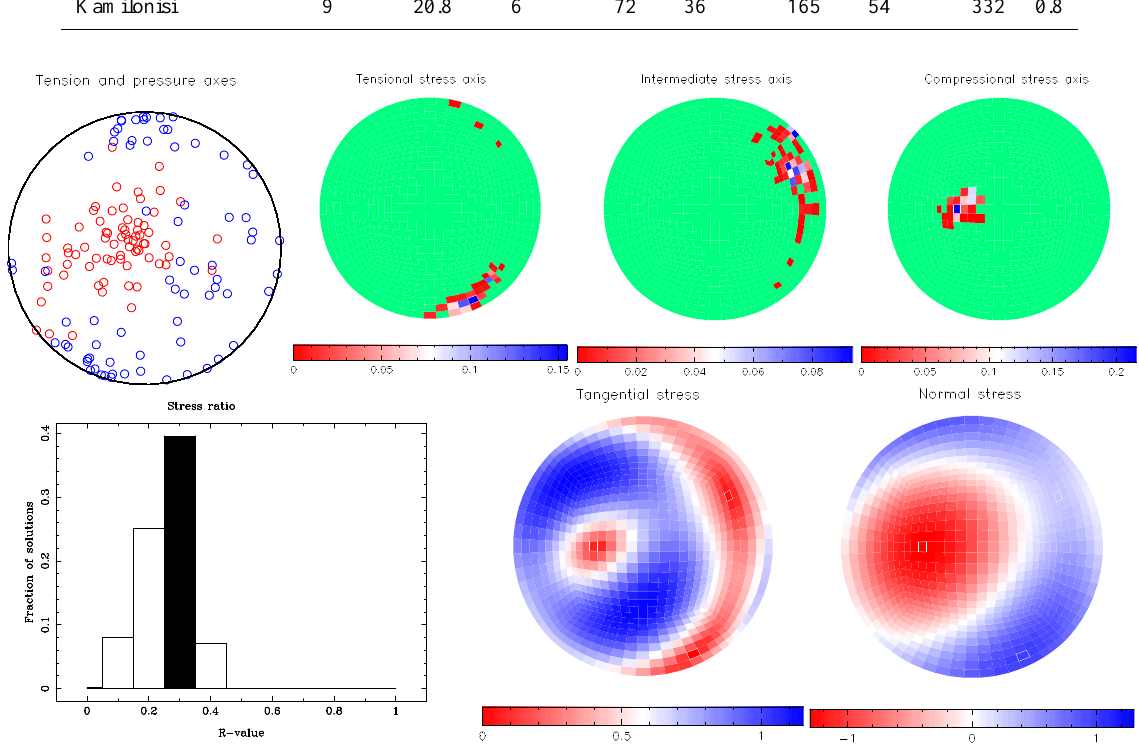
Fig. 5. Results of stress inversion for cluster of shallow earthquakes near Amorgos. Top row from left to right: location of tension (blue circles) and pressure axes (red circles) of focal mechanisms, 80 percent confidence region for least compressive (deviatoric tensional), intermediate and most compressive (deviatoric compressive) principal stress axes. Bottom row from left to right: distribution of R-values for best 80 percent of stress tensor solutions, magnitude of tangential stress and magnitude of normal stress versus surface normal.